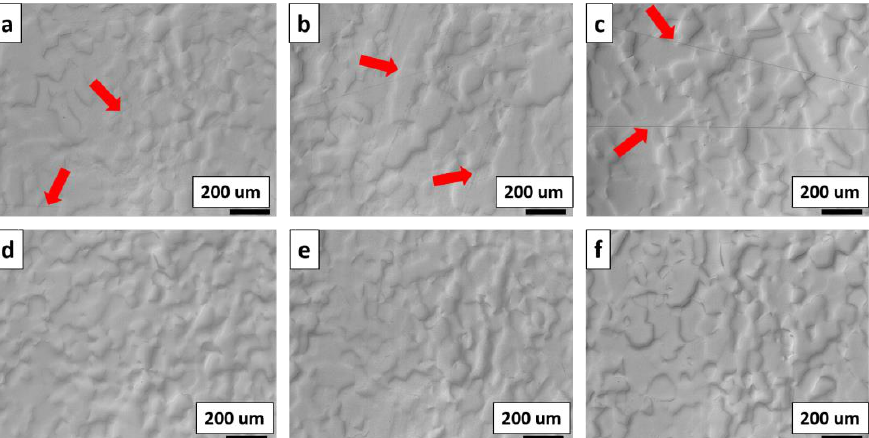
Figure 23. Photographs of the niobium surface after a full MP process at three different radii. Note: ( a ) Region 1 — inner edge, ( b ) Region 2 — center, and ( c ) Region 3 — outer edge for Step 1 with 9 µm, followed by Step 2 for 120 min. ( d ) Region 1—inner edge, ( e ) Region 2—center, and ( f )